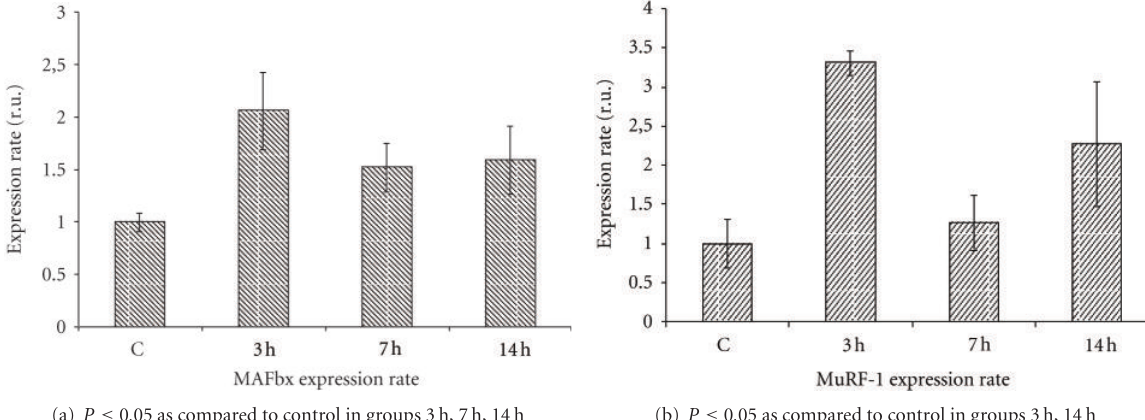
Figure 4: Changes in expression rate of MuRF-1 and MAFbx after di ff erent periods of unloading. HS3, HS7, HS14-hindlimb suspension for 3, 7, and 14 days, respectively. GAPDH and beta-actin were used as reference genes.